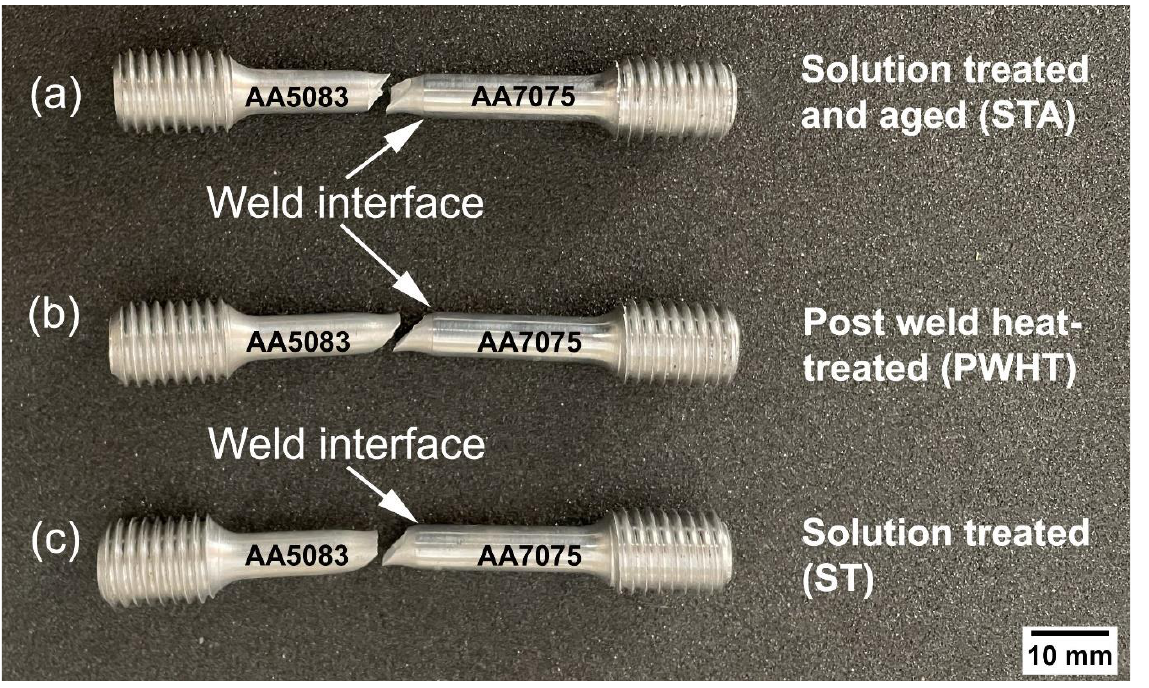
Figure 13. Showing tensile failure of ( a ) AA5083/AA7075-STA, ( b ) AA5083/AA7075-PWHT, and ( c ) AA5083/AA7075-ST.